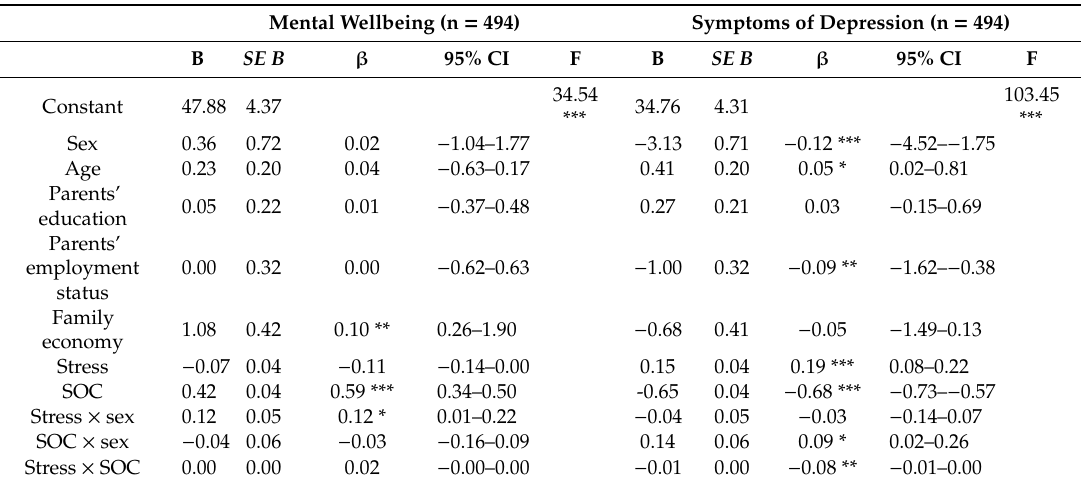
Table 4. Summary of the hierarchical regression analysis for variables associated with mental wellbeing and depressive symptoms.